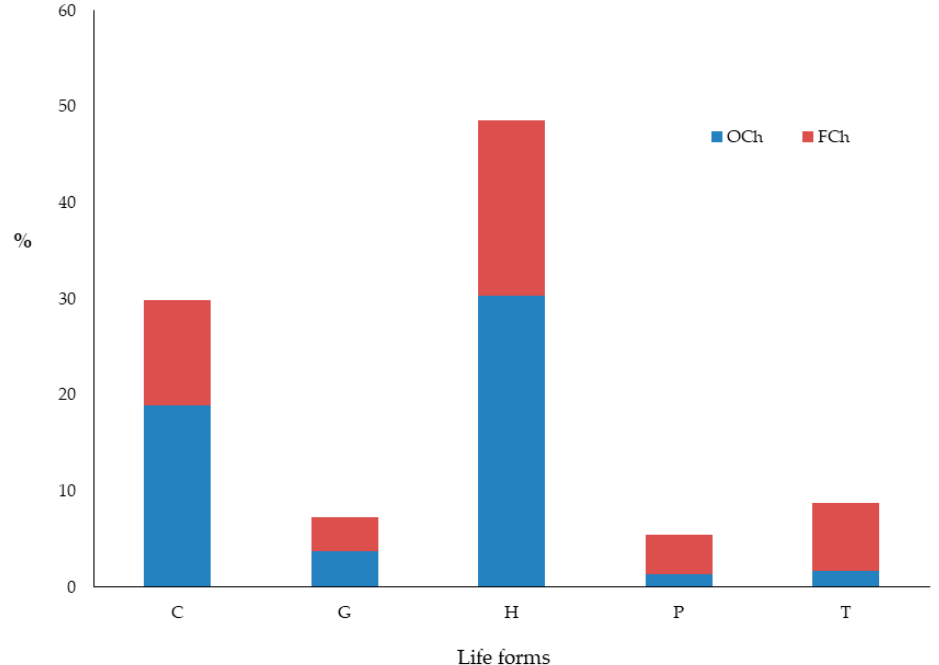
Figure 4. Life form proportions for obligate (OCh) and facultative (FCh) chasmophytes. Abbreviations: C = chamephyte, G = geophyte, H = hemicryptophyte, P = phanerophyte, T = therophyte.